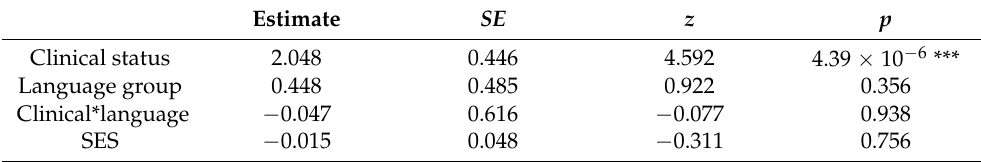
Table 5. Language-independent part: outcome of the mixed-effect logistic regression analysis. Estimate